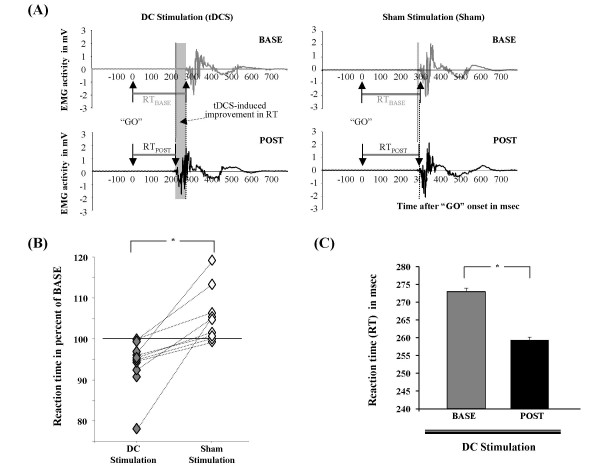
(A) Effects of tDCS on RT (representative trials). RT, measured as the time between the GO-signal and the onset of EMG response, is shown at baseline (RTBase) and post intervention (RTPost) in representative trials in the tDCS (left) and Sham (right) sessions. Note the shorter RTPost than RTBase after tDCS but not Sham (highlighted in gray). X axis shows time (msec) and Y axis shows EMG activity (mV) (B) Effects of tDCS on RT (individual subjects) RT after tDCS and Sham relative to baseline (BASE) in all subjects (values > 100 indicate longer RT, whereas those < 100 indicate faster RT relative to baseline). Note that RT improved in all subjects with tDCS, while most subjects experienced longer RT with Sham, probably reflecting mild fatigue over the length of the experimental session (see Discussion). Group analysis showed that RT improvements were significantly different from Sham (paired t-test, p < 0.05), an effect present in all subjects (see individual subject connecting lines). (C) Effects of tDCS on RT (group data) tDCS shortened significantly RT (RTBase, paired t-test, p < 0.05). Y axis shows reaction times in msec.